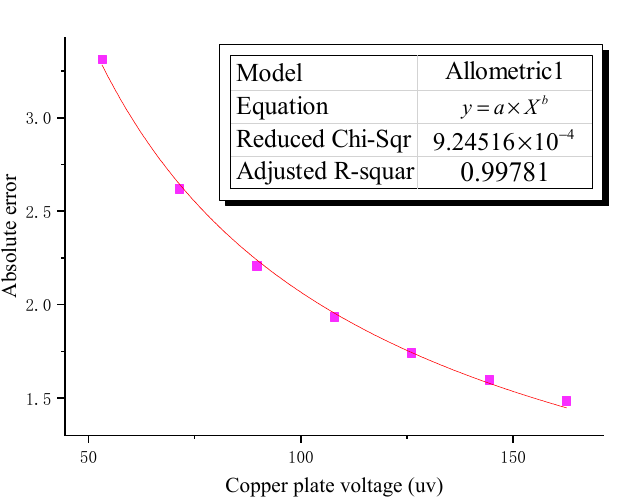
Figure 8. Error optimization fits the model result plot under external interference.